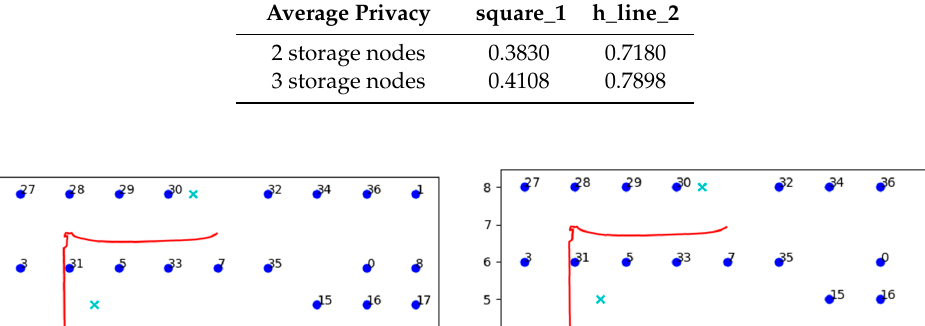
Table 2. Average privacy achieved by the DCA for the topology of 37 nodes.